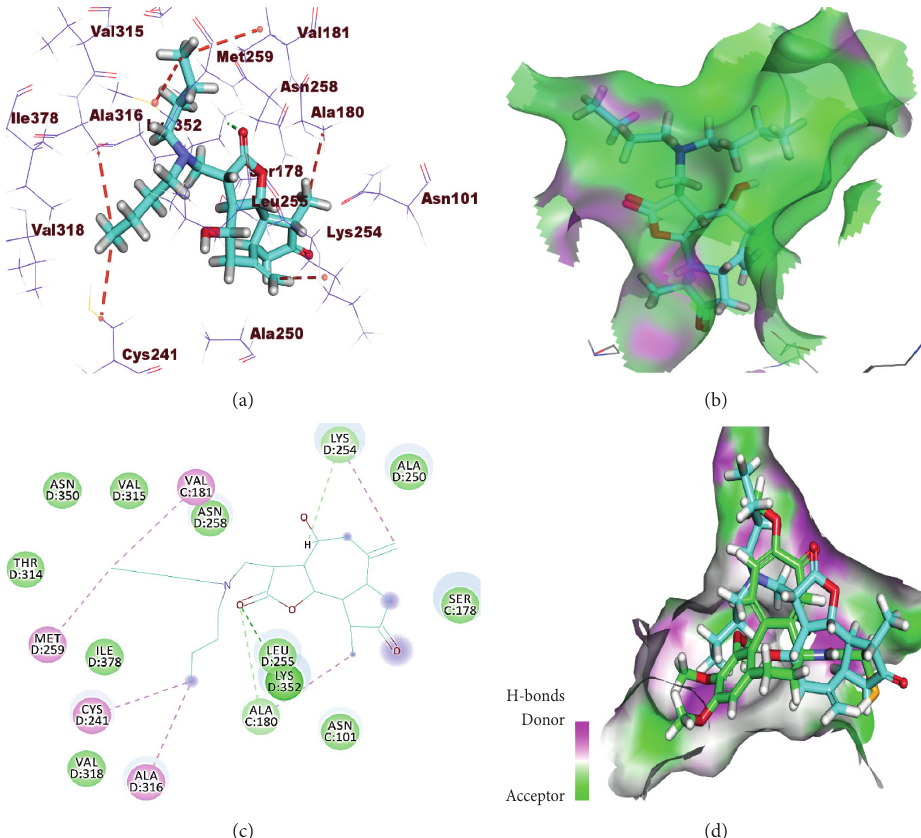
Figure 10: (a) 3D structure of compound 5, docked into the colchicine binding site. (b) Mapping surface showing compound 5, occupying the active pocket of colchicine binding site. (c) 2D structure of compound 5, docked into the colchicine binding site. (d) 3D alignment of compound 5 (carbon atoms in turquoise) with the DAMA-colchicine (carbon atoms in